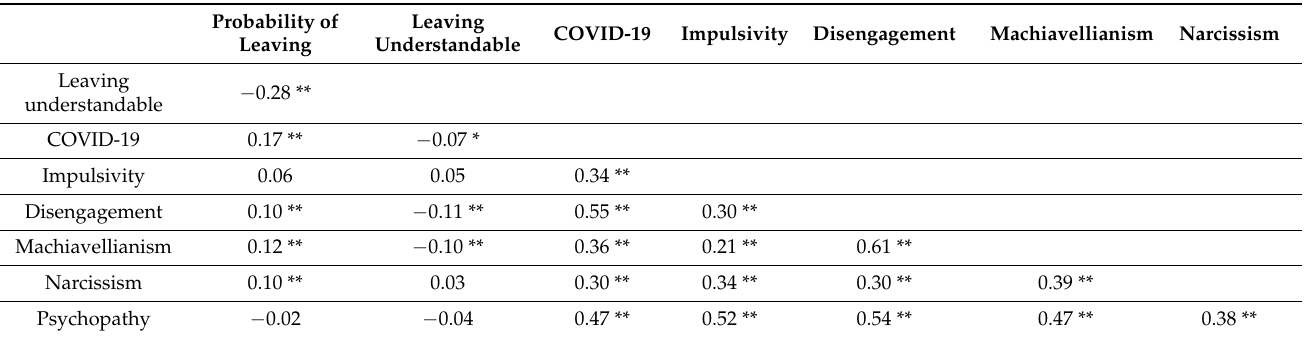
Table 4. Correlations between variables in the study.